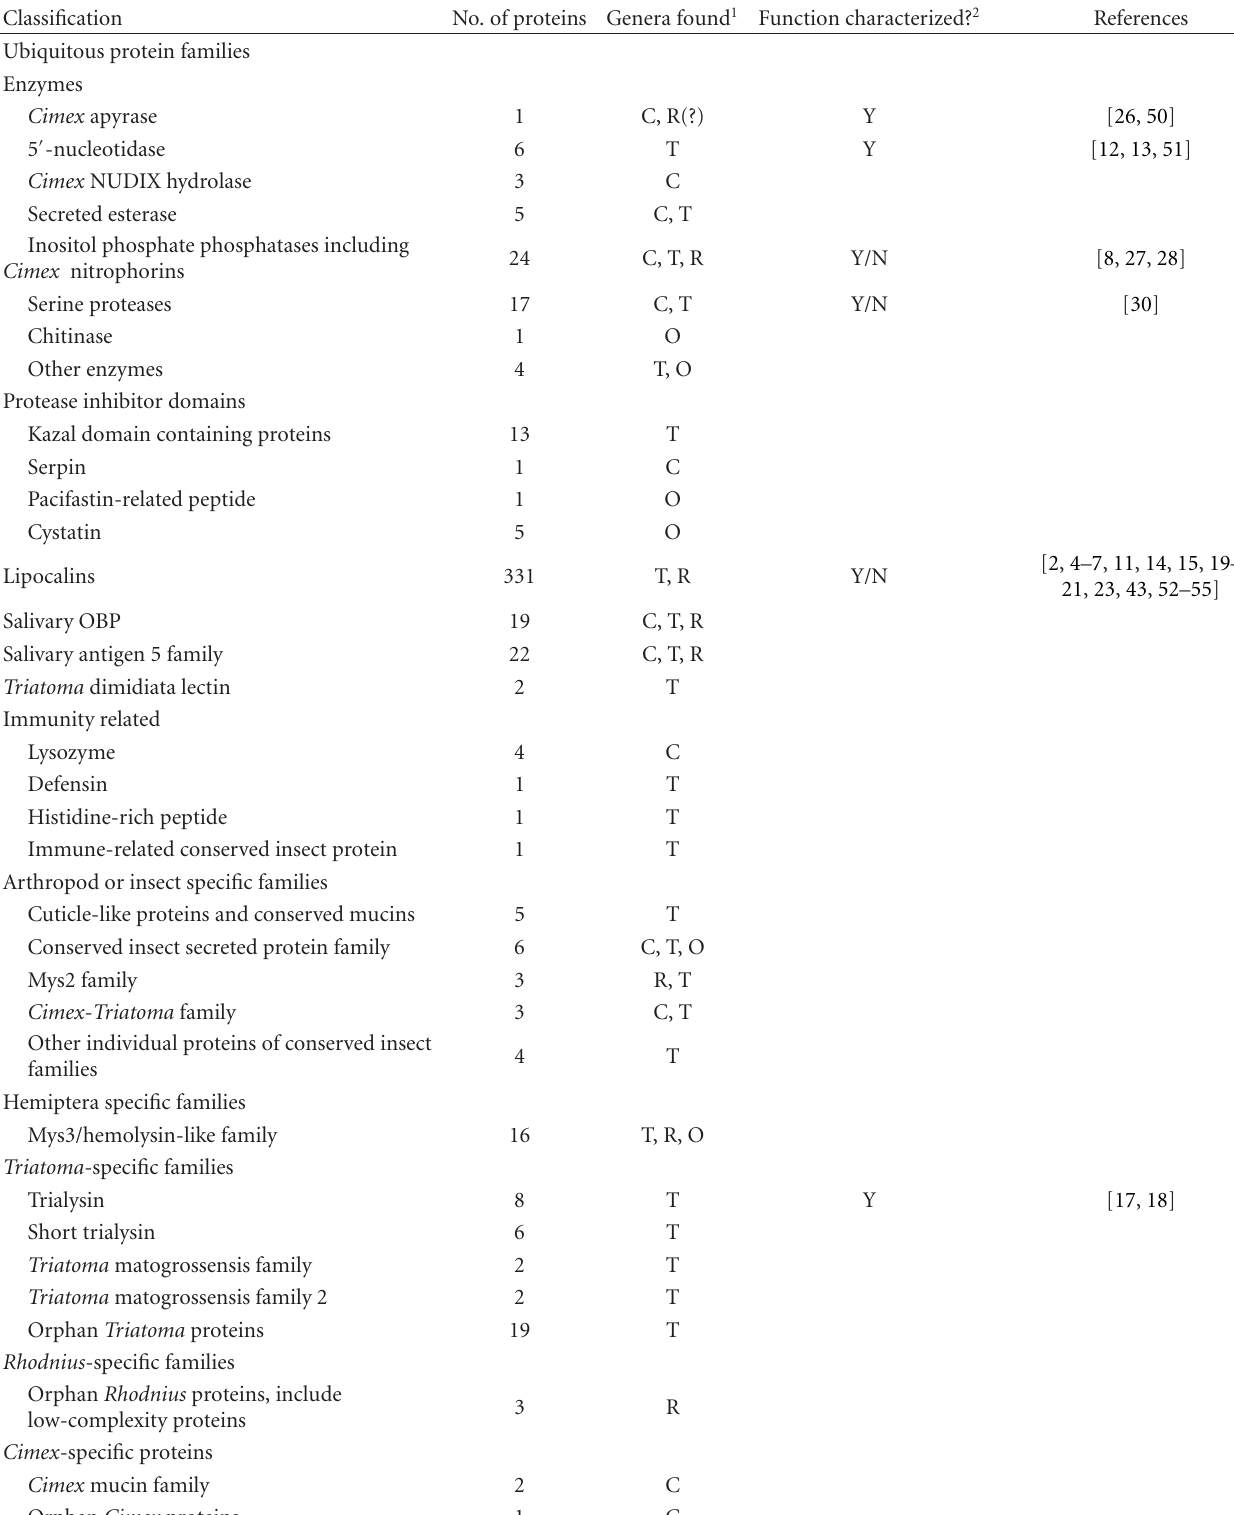
Table 3: Classification of the protein families relevant to secreted products in the Hemiptera/Heteroptera.